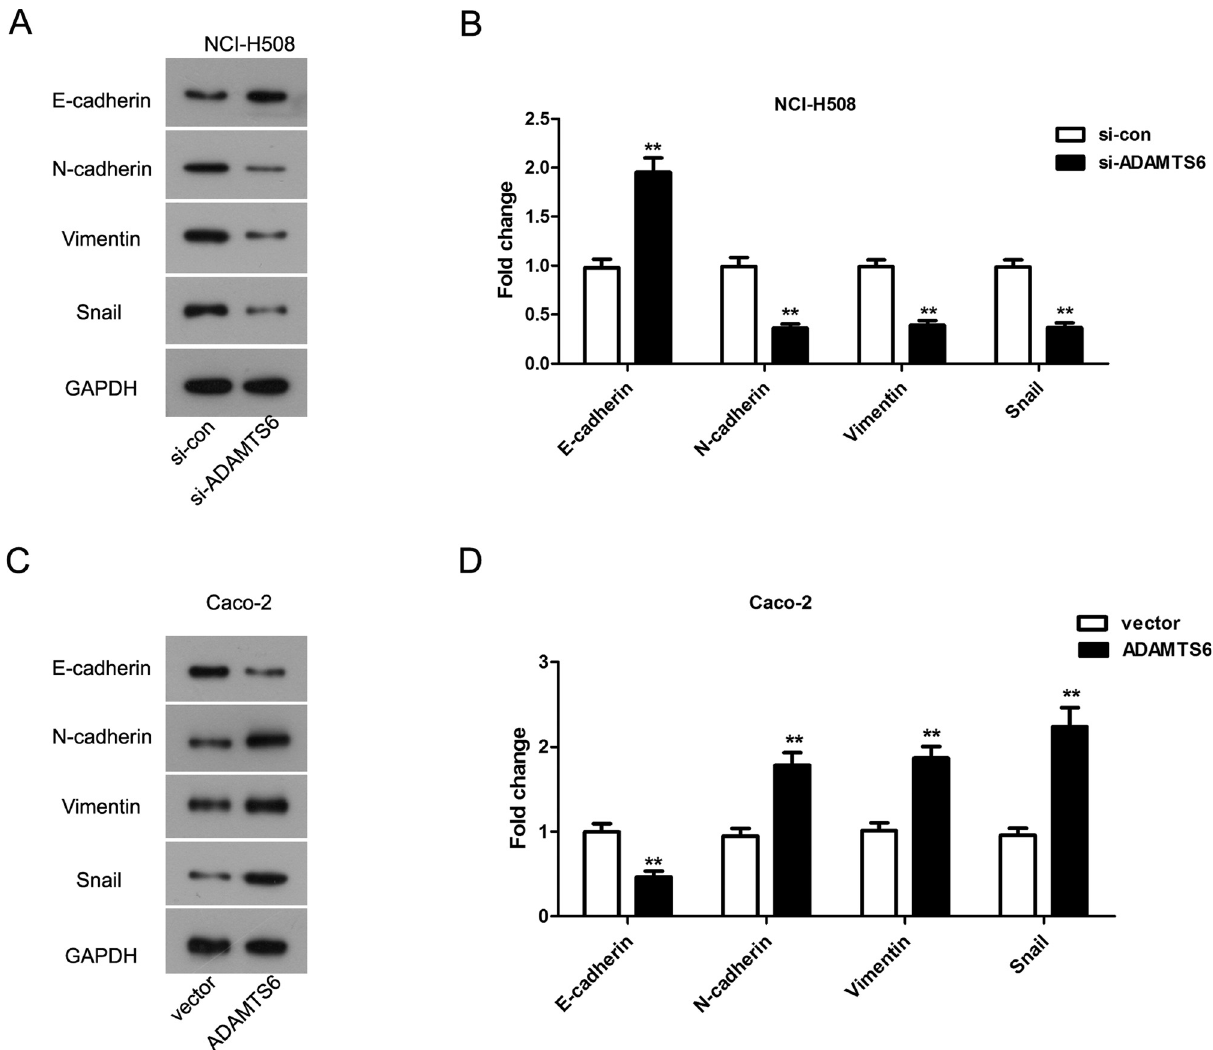
Figure 6 - The effect of ADAMTS6 on EMT-related markers was detected by western blotting. (A and B) The expression of E-cadherin, N-cadherin, Vimentin and Snail in NCI-H508 cells. ** P <0.01 vs. si-control group. (C and D) The expression of E-cadherin, N-cadherin, Vimentin and Snail in Caco-2 cells. ** P <0.01 vs. vector